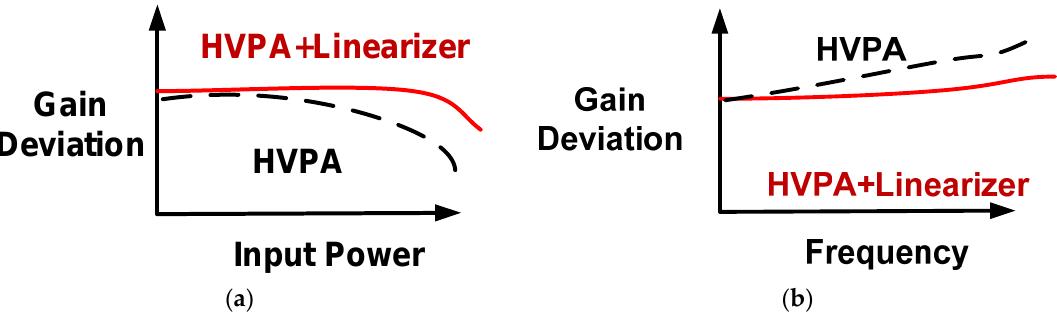
Figure 1. Gain deviation comparison between the high-voltage power amplifier (HVPA) with and without the linearizer as a function of ( a ) input power and ( b ) frequency (the black dashed lines and red solid lines represent the HVPA without and with the linearizer, respectively.